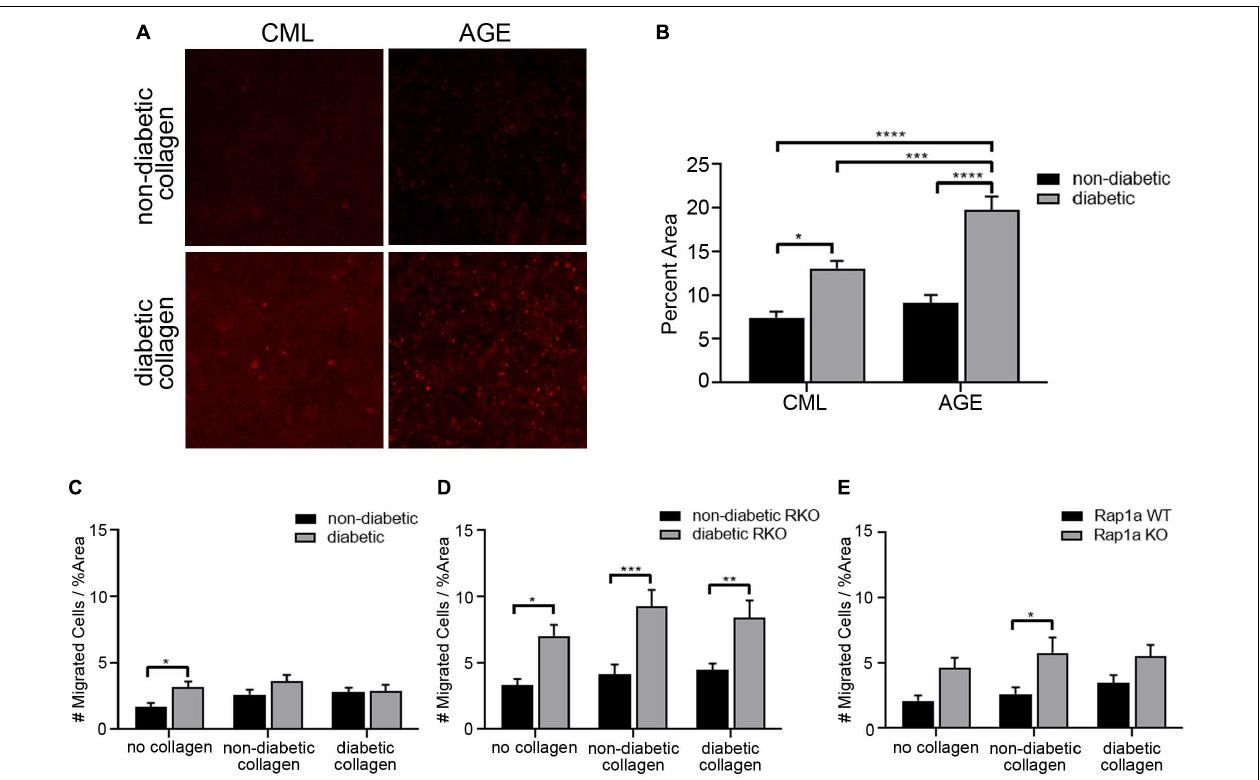
FIGURE 4 | The elevated levels of AGEs in diabetic collagen did not significantly impact fibroblast migration. (A) Immunofluorescence (100 × ; scale bar = 50 µ m) images for carboxymethyl lysine (CML) and advanced glycated end-products (AGEs) in non-diabetic collagen and diabetic collagen. (B) Graph depicting semi-quantification of CML and AGEs present in non-diabetic and diabetic collagen. Cardiac fibroblasts isolated from (C) non-diabetic and diabetic, (D) non-diabetic and diabetic RAGE knockout, and (E) Rap1a WT and KO mice were plated on either no collagen (results shown in Figure 1 ) non-diabetic collagen, or diabetic collagen. The number of migrated cells were normalized to percent scratch area. Data are mean ± SEM with a two-way ANOVA and a Sidak’s post hoc test, n = 10–13. A red line was set at y = 1 Migrated Cells/%Area and was used for comparison across cardiac fibroblast genotypes ( * p < 0.05, ** p < 0.01, *** p < 0.001, **** p <